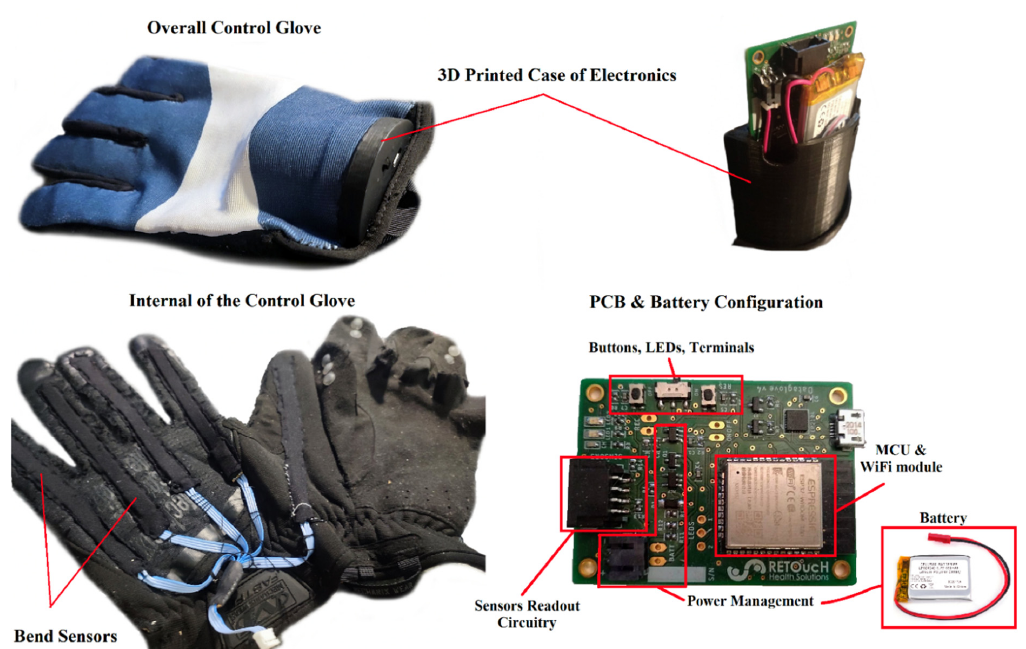
Figure 4. The overall configuration of the control glove and its